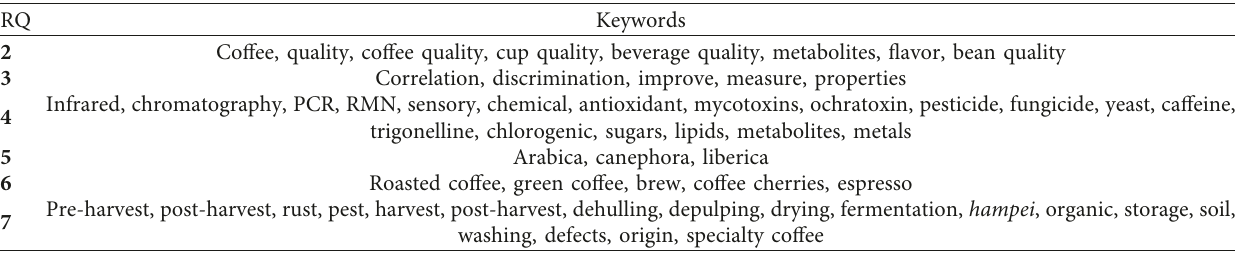
Table 1: Keywords based on the research